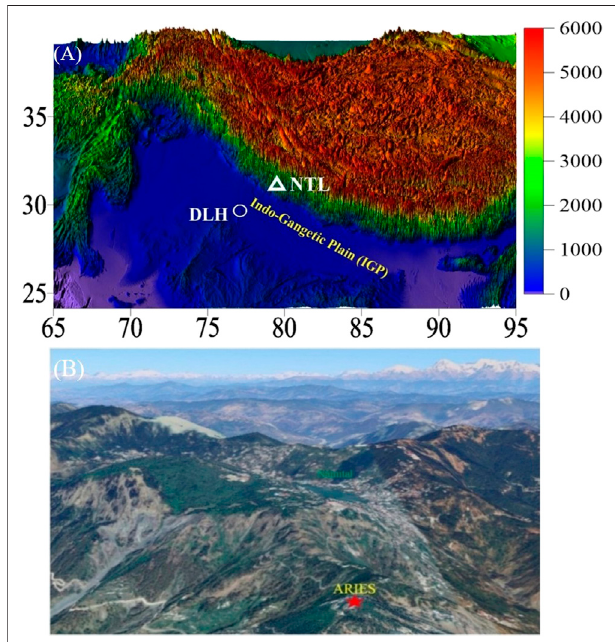
FIGURE 1 | (A) Location of the observational site ARIES, Nainital (NTL: 29.4 ° N; 79.5 ° E; 1958 m msl) in the central Himalayas. The location of country capital Delhi (DLH) is also shown. The surface elevation above the mean sea level (meter) is shown in the color scale. The Indo-Gangetic Plain (IGP) regionisalsoshown, (B) Zoomedtopographyoftheobservationsiteisshown where the high-altitude Himalayas and snowline can also be seen far away, towards the north of the